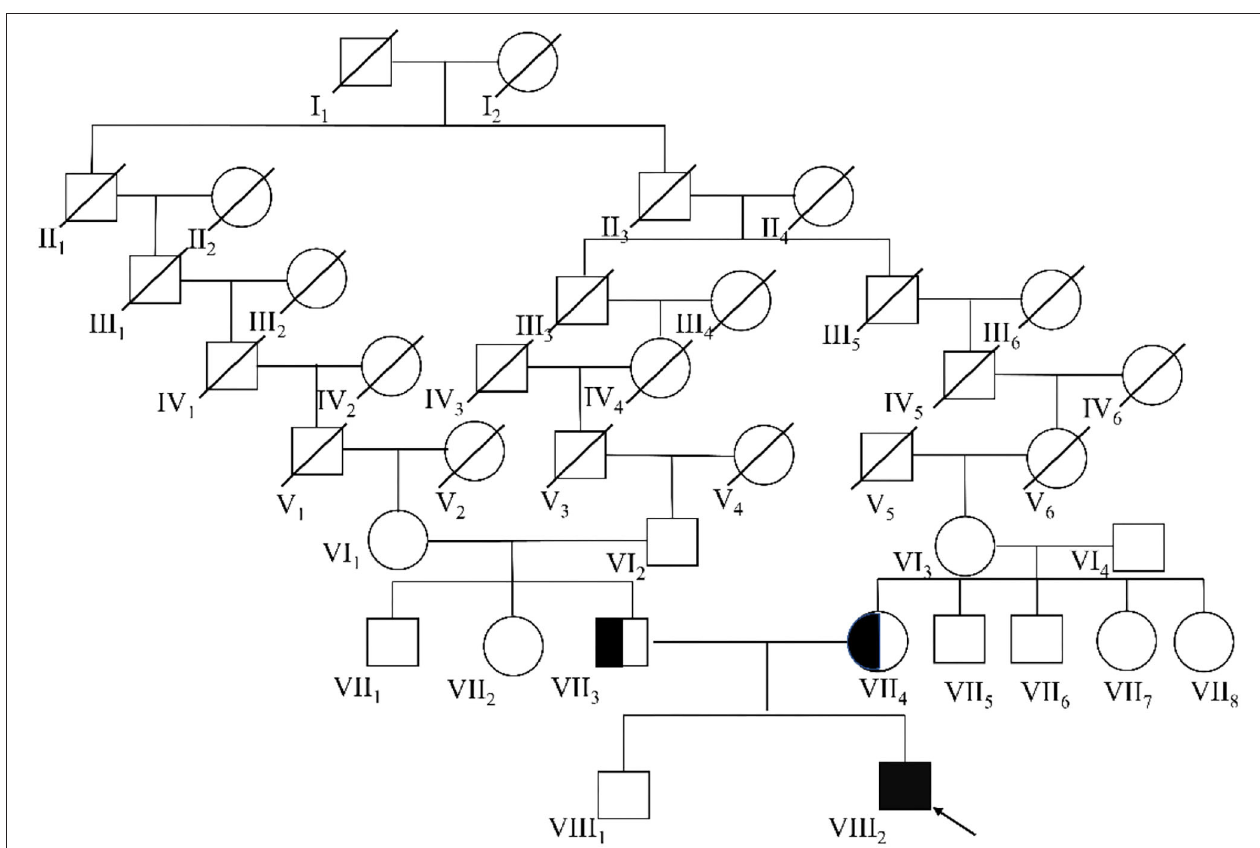
FIGURE 2 | The complete eight-generational Chinese pedigree. The proband affected by ITGA7 is indicated with an arrow and a dark